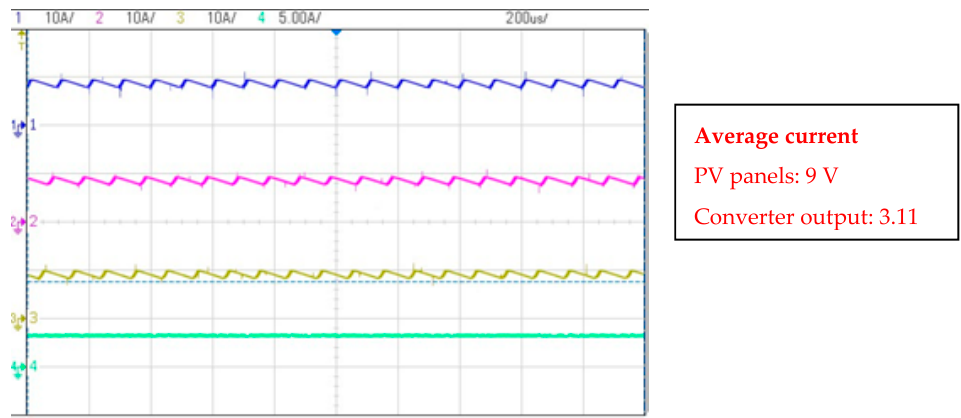
Figure 19. Experimental waveforms. PV panels’ currents: PV panel 1 (blue), PV panel 2 (pink), and panel 3 (yellow); scale: 25 V/div. Converter output voltage (green); scale: 500 V/div. Base time: 200 PV panel 3 (yellow); scale: 10 A/div. Converter’s output current (green); scale: 5 A/div. Base time: µs/div. 200 µs/div.